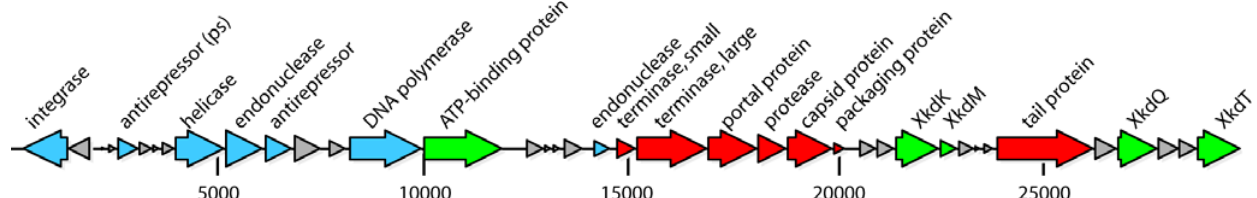
Figure 5. Linear map of prophage located between nts 2,024,189 and 2,053,649 in FNP. Replication and regulatory ORFs are colored blue, ORFs encoding structural proteins are red, ORFs encoding proteins with homologs in the nr database but of unknown function are colored green, and hypotheticals are shaded gray.